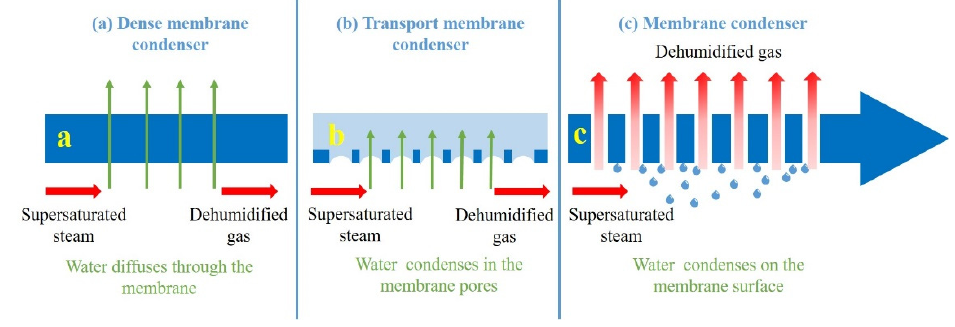
Figure 1. Dehydration mechanisms of different membranes: ( a ) DMC, ( b ) TMC, ( c ) MC